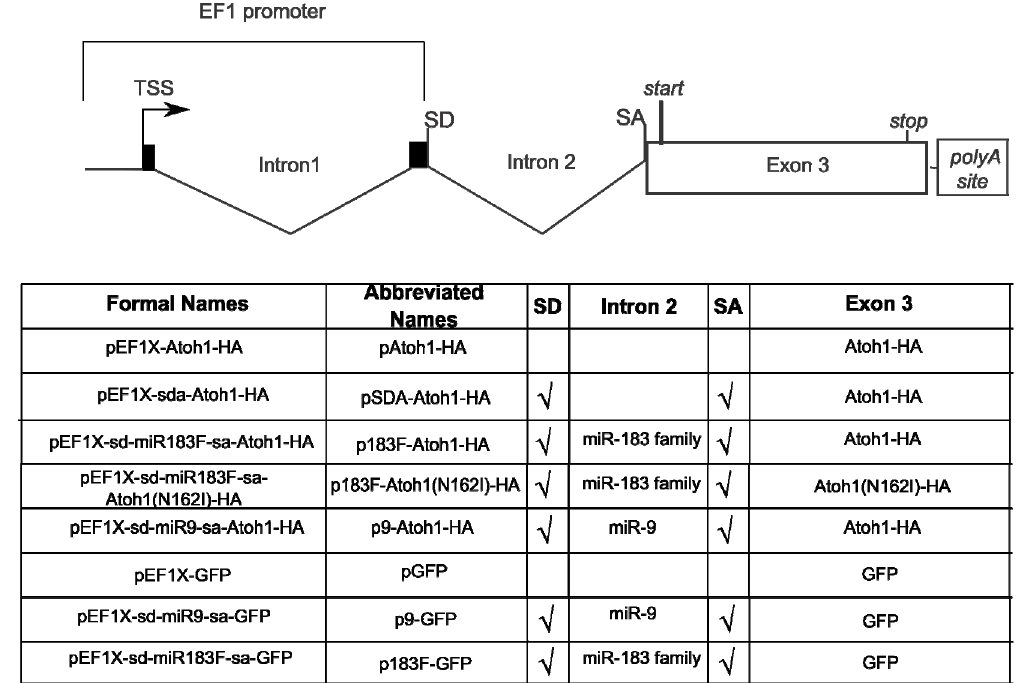
Figure 2. Content and design of overexpression vectors. Each overexpression vector discussed in the paper is listed with its formal name, abbreviated name, and contents. Black boxes represent exons. Intron 1 and exons 1 and 2 were present within the plasmid backbone prior to modification. Checkmarks indicate the presence of artificial intronic flanking sequences. Empty spaces indicate a specific component is not found within that particular vector. TSS: transcription start